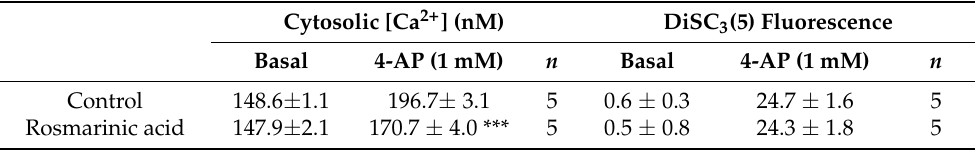
Table 1. Effect of rosmarinic acid on cytosolic Ca 2+ levels and synaptosomal membrane potential in rat cerebrocortical